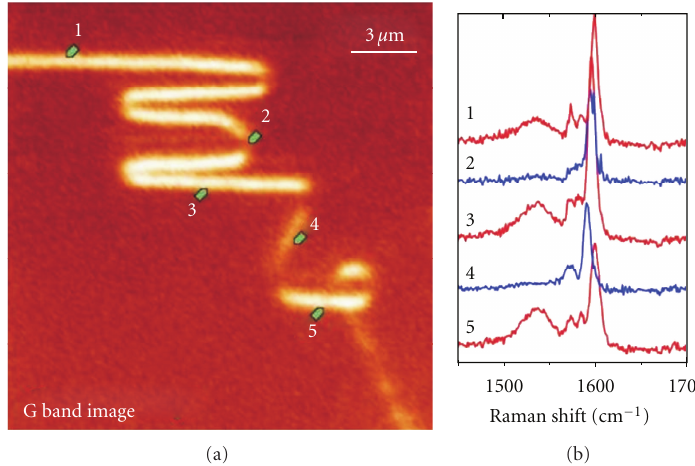
Figure 6: (a) Confocal image of the G band integrated intensity ( E laser = 1 . 96 eV, spatial resolution ∼ 500 nm) for SWNT serpentine on (1 1 0 1) quartz. The spectral intensity is stronger in segments aligned along the steps because of the light polarization dependence for the Raman scattering [8]. (b) The G band at di ff erent points on the same serpentine shown in (a). An additional broad peak at the G band ( ∼ 1540cm − 1 ) has been observed on the flat sections (spectra 1, 3, and 5), indicating a metallic character. This additional peak disappears in spectra 2 and 4, indicating a semiconducting character (adapted from [30]).